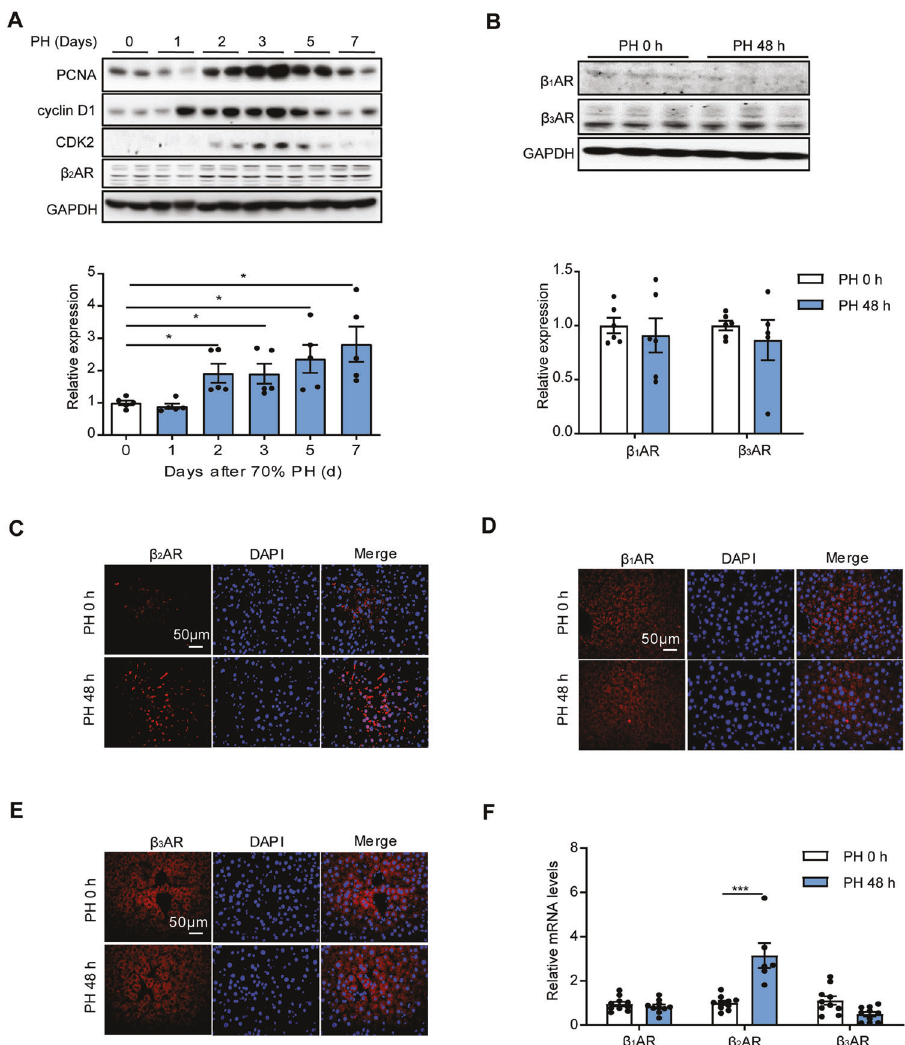
Fig. 1 β 2 AR was upregulated during liver regeneration induced by 70% PH. A Protein expression levels of β 2 AR, PCNA, cyclin D1 and CDK2 in the liver at the indicated times post PH. B Protein expression levels of β 1 AR and β 3 AR 48 h post PH ( n = 5 – 6). C – E Immuno fl uorescence staining of PH mouse livers for the indicated proteins. F The mRNA levels of β ARs 48 h post-PH. Data are shown as means ± SEM. * P < 0.05, ** P < 0.01, *** P < 0.001 by two-tailed Student ’ s t test. using Western blotting. Concomitant with increased expression of proliferation markers such as proliferating cell nuclear antigen (PCNA), cyclin D1, cyclin-dependent kinase 2 (CDK2), β 2 AR protein levels started increasing at 48 h post-PH (Fig. 1A). Nevertheless, the protein levels of β 1 AR and β 3 AR were not changed by PH (Fig. 1B). Additionally, β